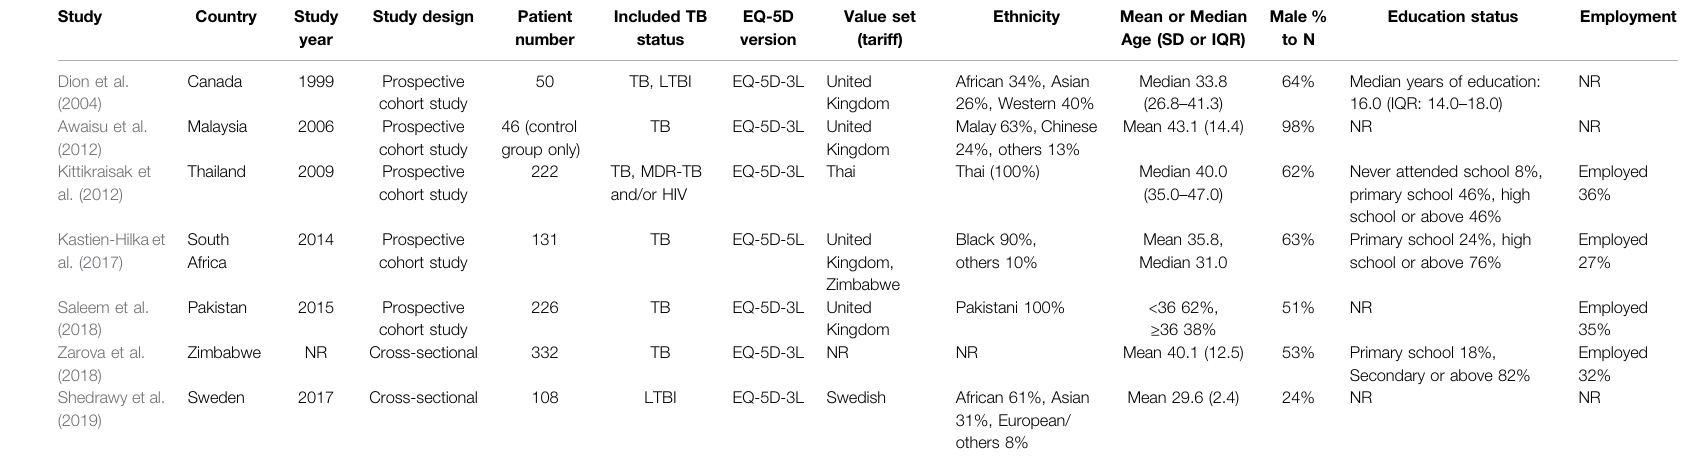
TABLE 1 | Characteristics of Selected Studies and